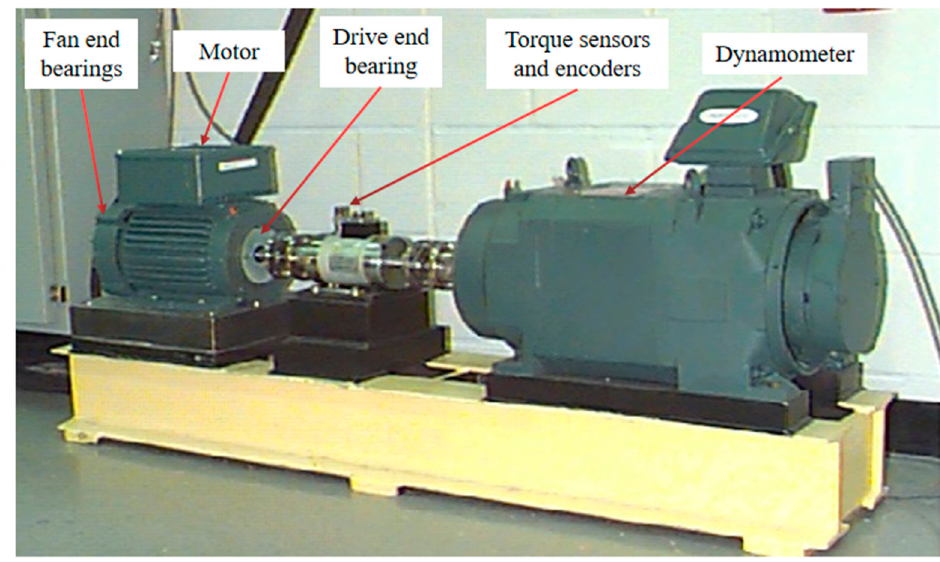
Figure 8. Equipment for experimental data acquisition (from Case Western Reserve University (CWRU)).